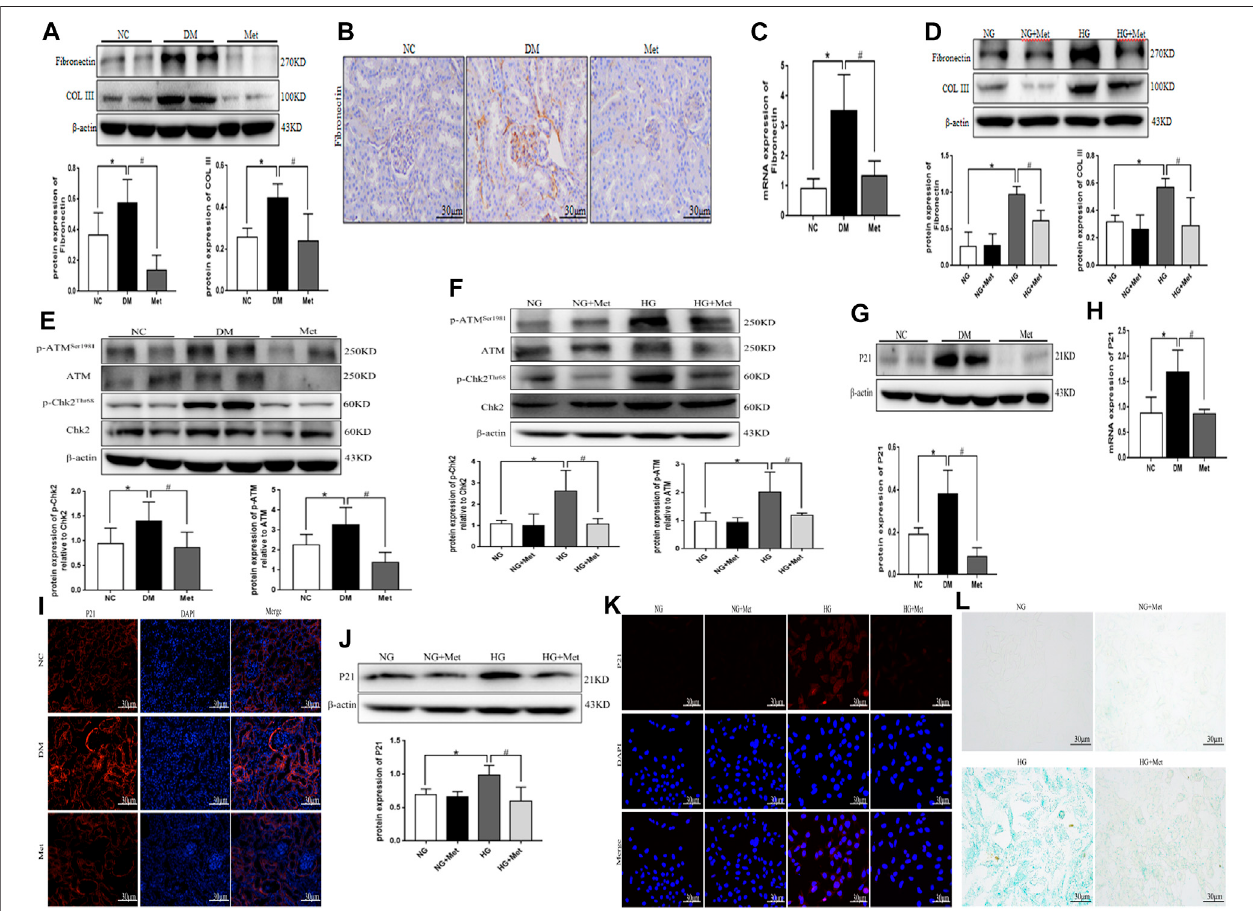
FIGURE 3 | Metformin improves the process of renal fi brosis and the degree of DNA damage and cellular senescence in the high-glucose state. (A) Western blot analysis of Fibronectin and COL III in renal cortex of mice in each group (n = 6, * p < 0.05 vs. NC, # p < 0.05 vs. DM). (B) Immunohistochemical staining of Fibronectin in renalcortexofmiceineachgroup. (C) Real-timePCRanalysisofFibronectininrenalcortexofmiceineachgroup(n=6,* p < 0.05vs.NC, # p < 0.05vs.DM). (D) Western blot analysis of Fibronectin and COL III in mRTECs (n = 3, * p < 0.05 vs. NG, # p < 0.05 vs. HG). (E) Western blot analysis of ATM, p-ATM Ser1981 , Chk2, and p-Chk2 Thr68 in renal cortex of mice in each group (n = 6, * p < 0.05 vs. NC, # p < 0.05 vs. DM). (F) Western blot analysis of ATM, p-ATM Ser1981 , Chk2, and p-Chk2 Thr68 in mRTECs(n=3,* p < 0.05vs.NG, # p < 0.05vs.HG). (G) WesternblotanalysisofP21intherenalcortexofmiceineachgroup(n=6,* p < 0.05vs.NC, # p < 0.05vs.DM). (H) Real-time PCR analysis of P21 in the renal cortex of mice in each group (n = 6, * p < 0.05 vs. NC, # p < 0.05 vs. DM). (I) Tissue immuno fl uorescence of P21 in renal cortexofmiceineachgroup. (J) WesternblotanalysisofP21inmRTECs(n=3,* p < 0.05vs.NG, # p < 0.05vs.HG). (K) Cellularimmuno fl uorescenceofP21inmRTECs. (L) β -Galactosidase staining in mRTECs.